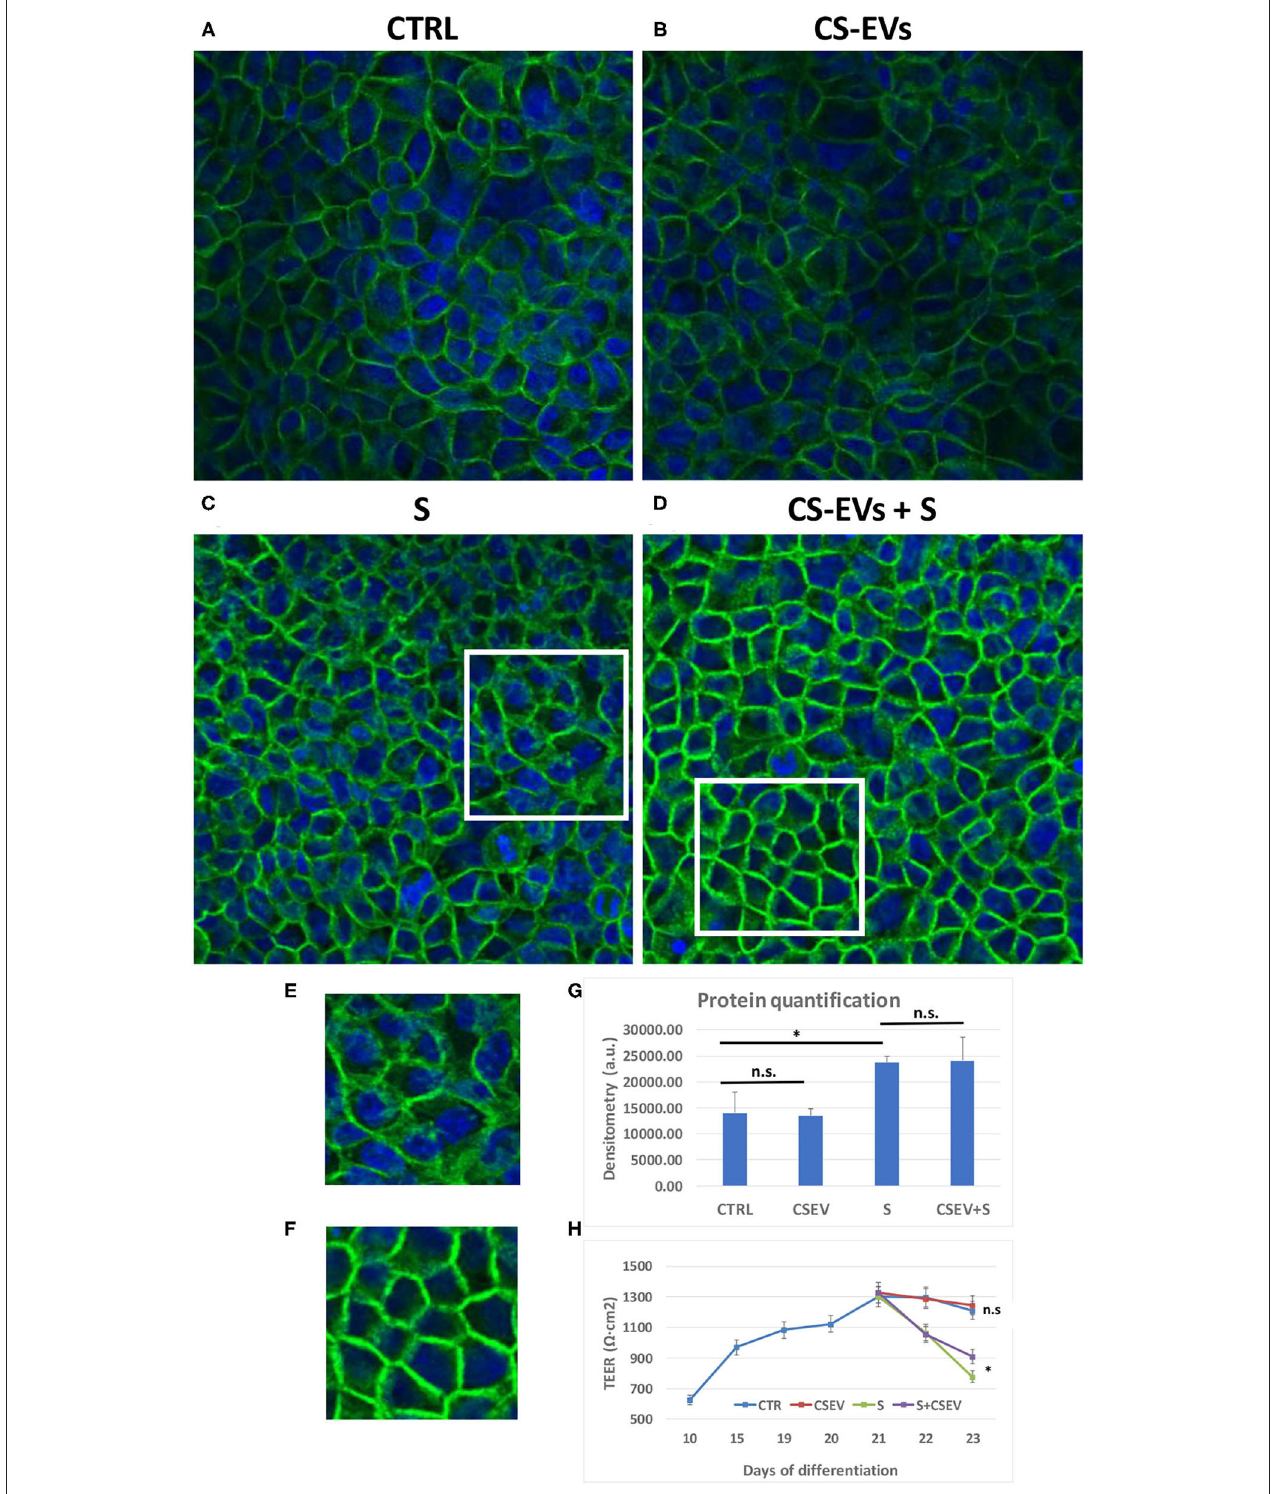
FIGURE 6 | Localization of Occludin within cellular junctions. Differentiated CaCo-2 cells (A) were treated with 20 µ g/ml CS-EVs (B) , a cytokine cocktail (TNF- α , IL-1 β , and IFN- γ , 10ng/ml each) without (C) and with a pretreatment with CS-EVs for 1 day (D) . The representative magnifications (E,F) outlined the different distributions of occludin compared to control cells. In (G) , we reported the quantification of fluorescence intensity in the various conditions, whereas, in (H) , we reported the TEER measurements in the various conditions (stimulation after complete differentiation). Significant differences have been indicated by an asterisk. (* = p -value < 0.05).